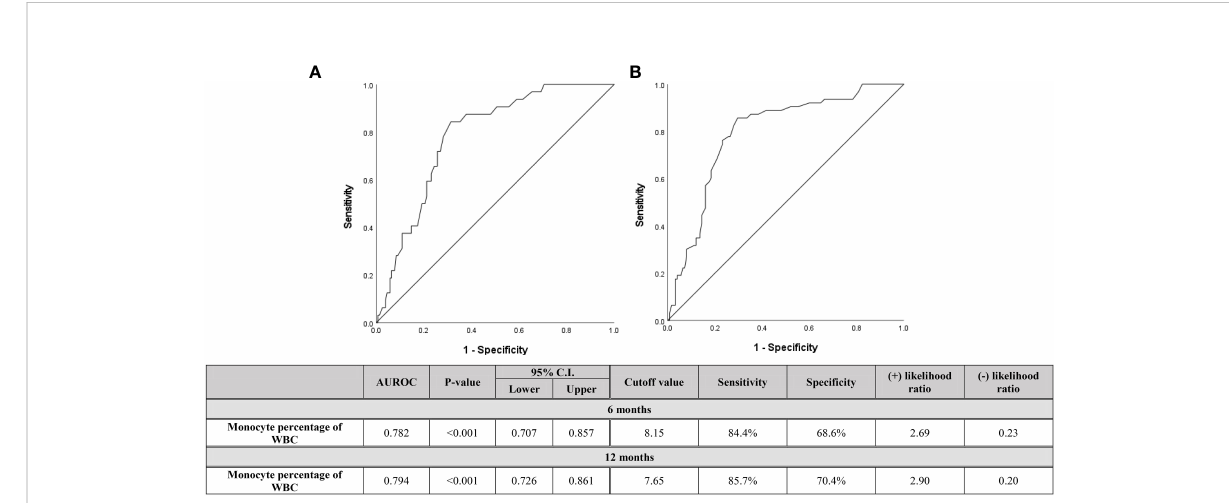
FIGURE 4 Diagnostic capabilities with area under operating characteristic curve of the serum monocyte percentage of WBC for assessing relapse within (A) 6 months and (B) 12 months after discontinuation of biologics in both pediatric CD and UC patients.